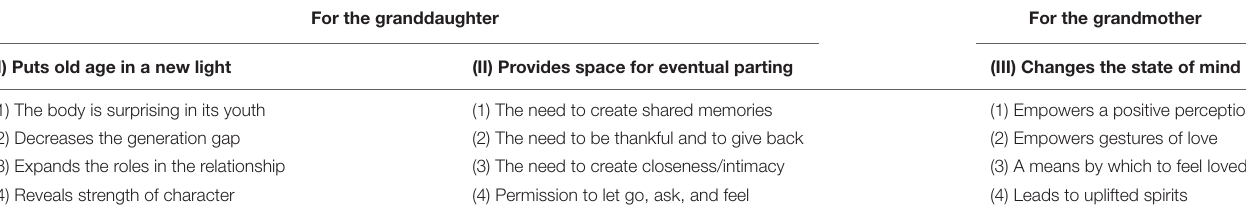
TABLE 2 | Significance of free-form dance in meetings of adult granddaughters with their grandmothers.